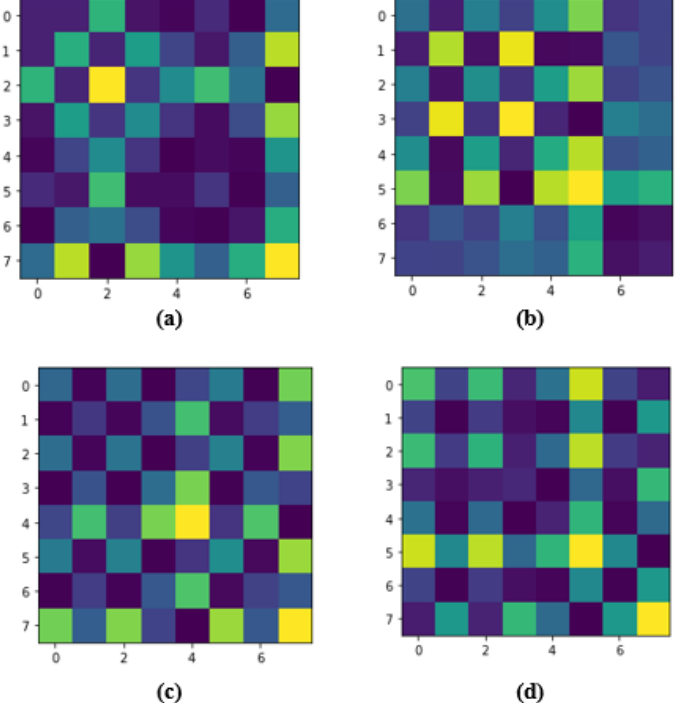
Figure 2 . Illustration of random GAF images transformed from the normalized WESAD dataset: ( a )